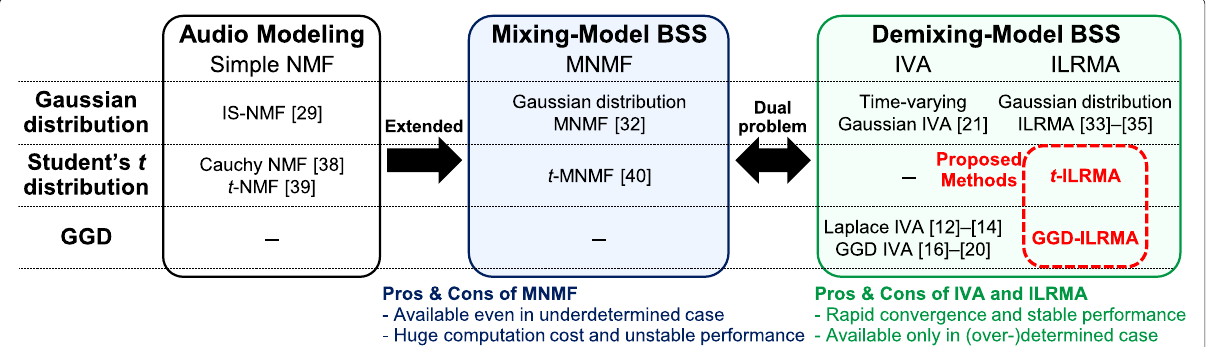
Fig. 1 Relationship among conventional methods based on Gaussian, Student’s t , and generalized Gaussian distributions. NMF-based low-rank audio source modeling is extended to a multichannel signal, resulting in MNMF, which estimates the mixing system for solving the BSS problem. ILRMA can be considered as a dual problem of MNMF because it estimates the demixing system using the NMF source